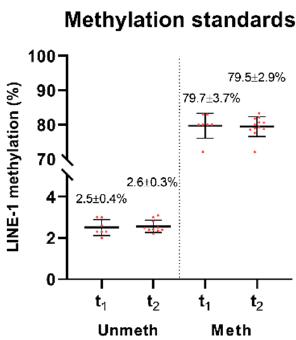
Figure 4. LINE-1 methylation of unmethylated and methylated bisulfite-converted DNA standards. No significant changes could be observed in both DNA controls over time. Unmeth: unmethylated standard samples, Meth: methylated standard samples, t1: first measurements, t2: measurements after two years .